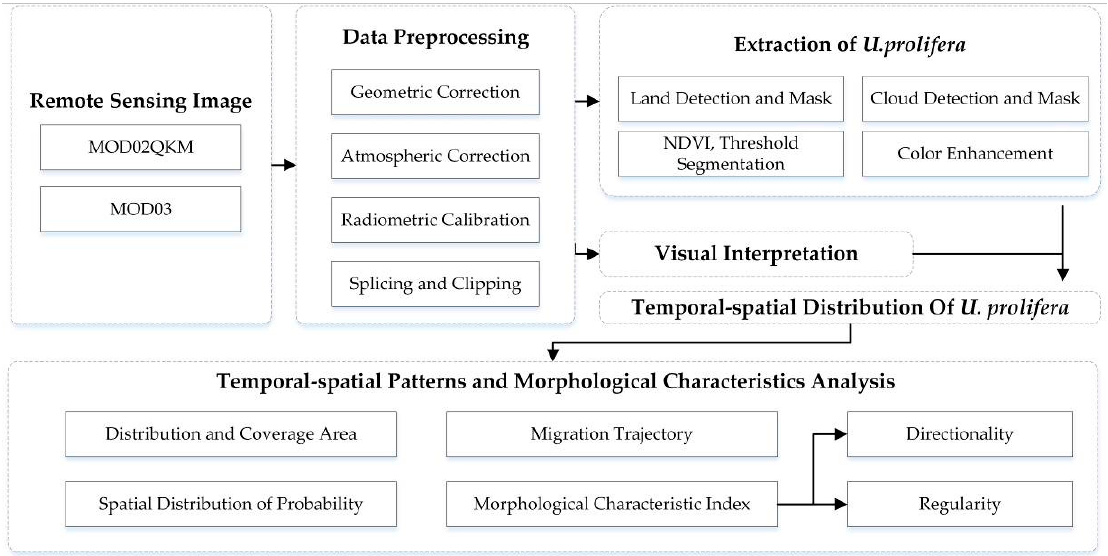
Figure 2. Research flow chart for this study.